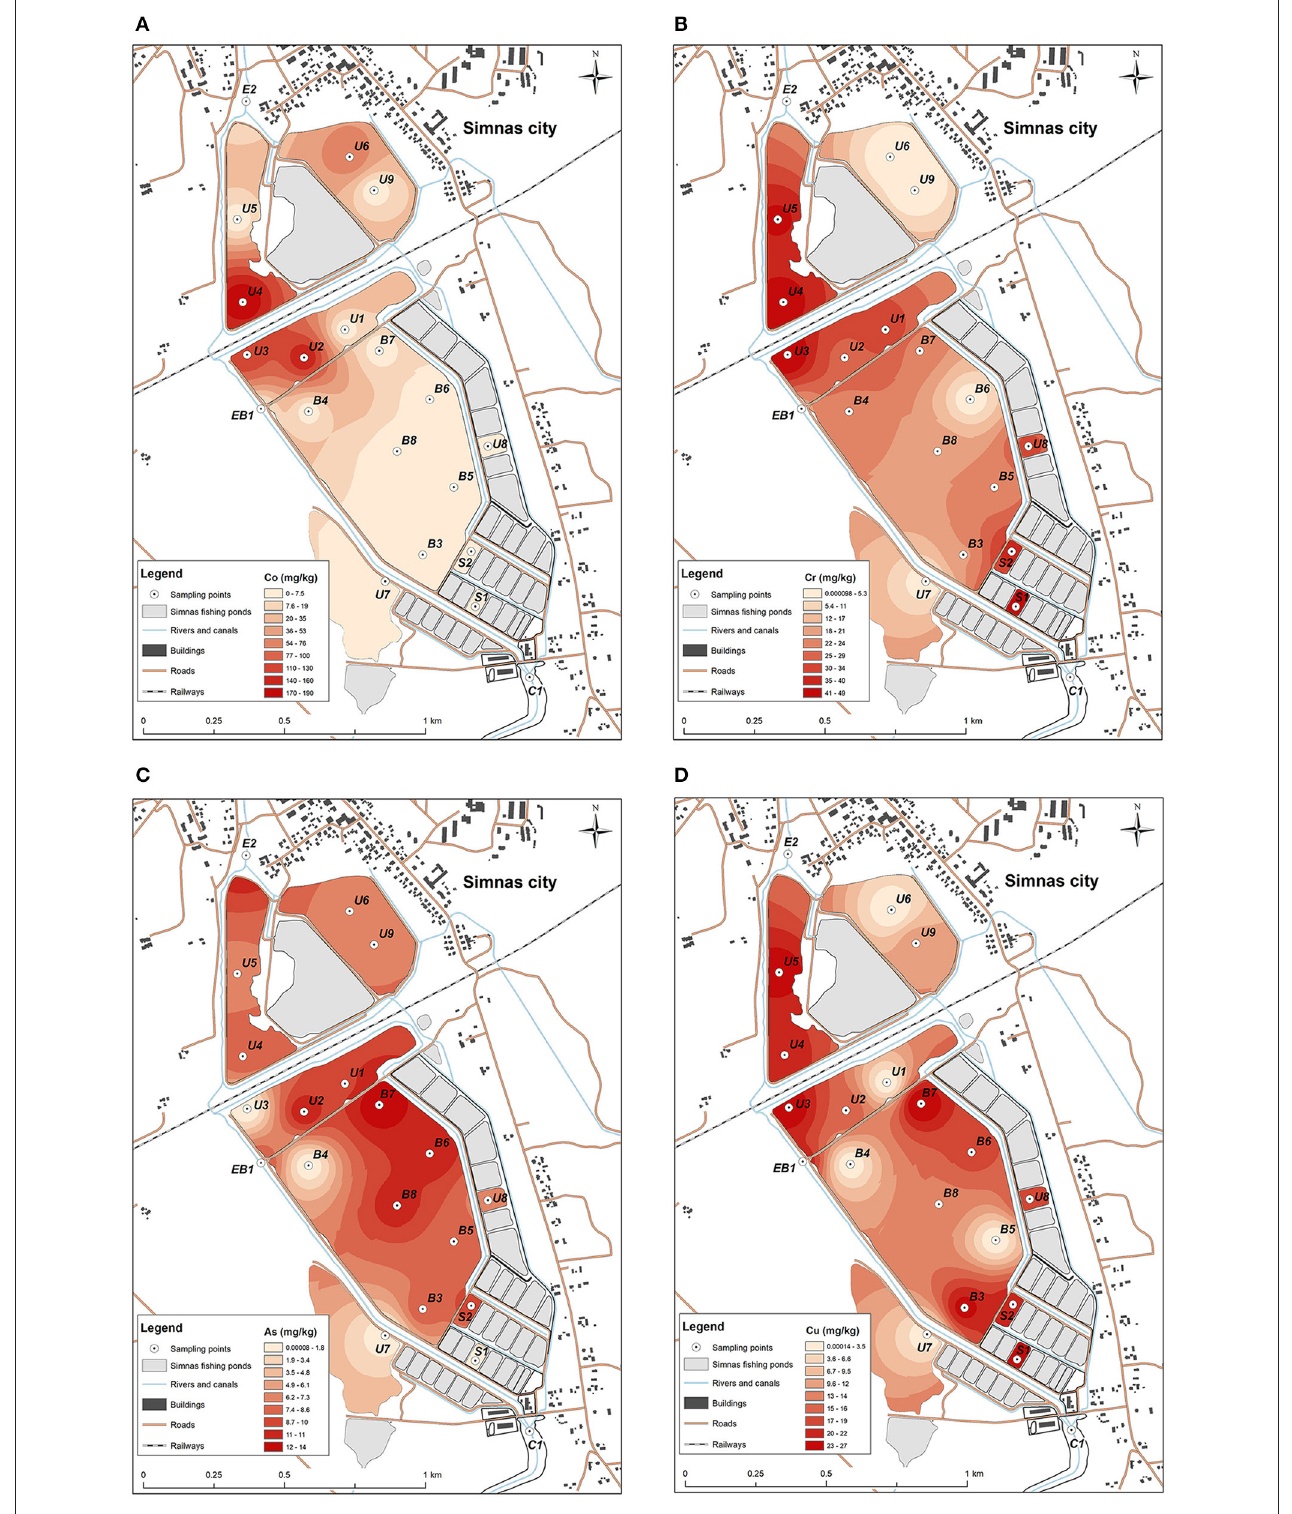
FIGURE 2 | Distribution of heavy metals concentrations: (A) Co, with the highest concentration detected in U4, U3, and U2 sediment samples, (B) Cr, most abundant in small nursery ponds S1, S2, and U4, U5, U3, U8, (C) As, mostly detected in the sediments from the main pond at B8, B7, B6, and U2 sampling point from the unused pond, (D) Cu, prevalent in all the testes ponds, highest concentrations determined in U4, U5, U3, B3, B7, U8, S1 and S2 locations.